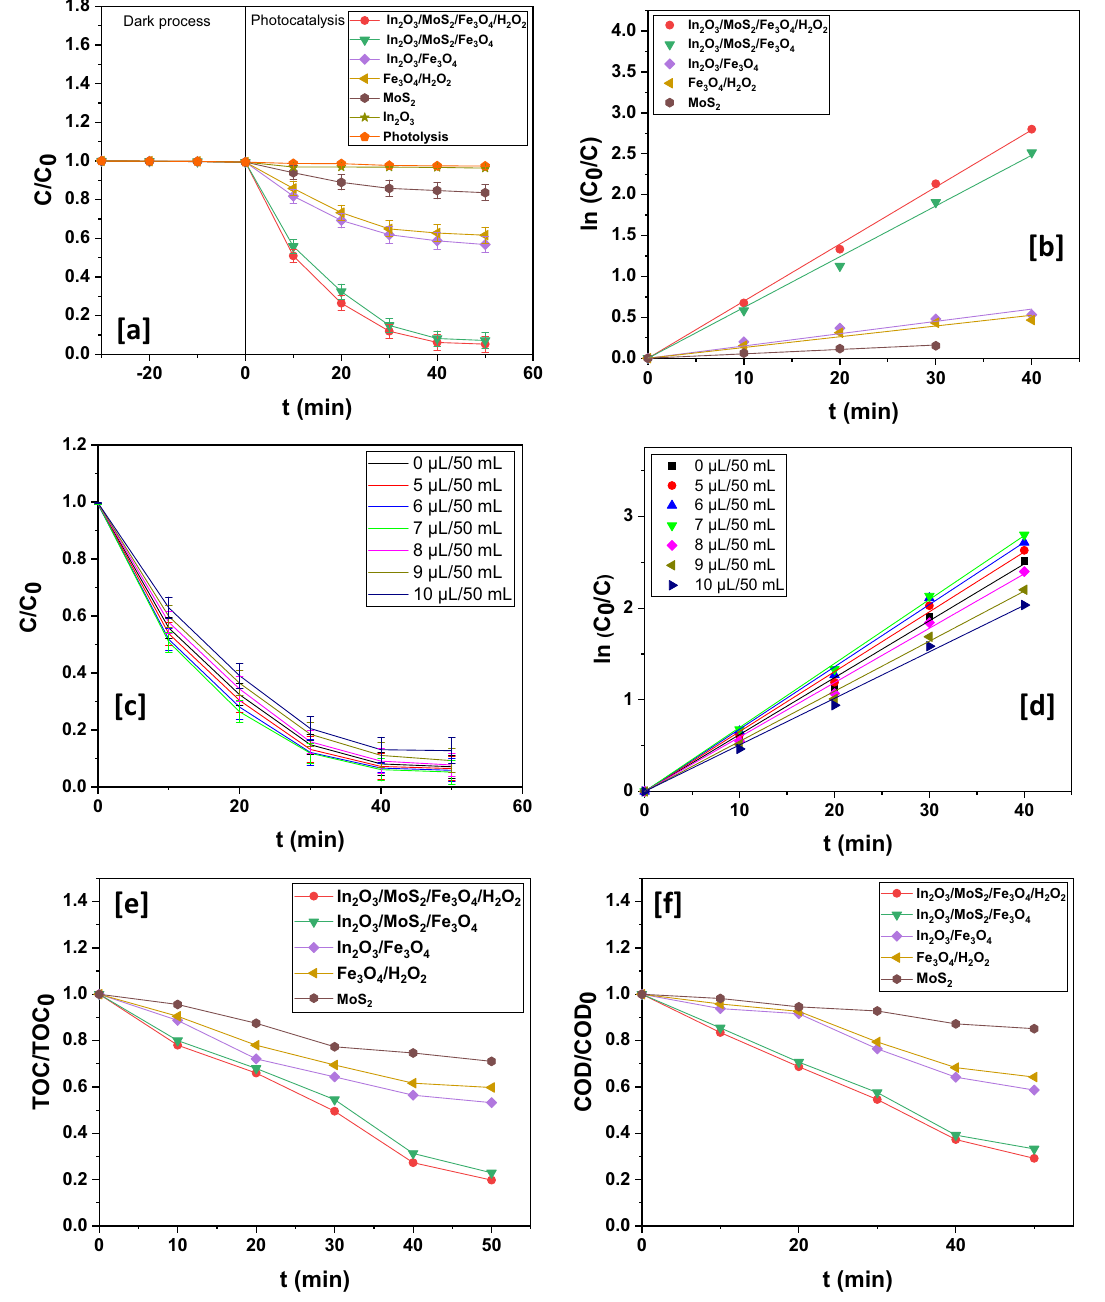
Figure 8. ( a ) Photodegradation dynamic curves of esomeprazole and ( b ) kinetics for different catalysts. ( c ) Photodegradation dynamic curves of esomeprazole at different H 2 O 2 doses over In 2 O 3 /MoS 2 /Fe 3 O 4 and ( d ) its corresponding kinetics. ( e ) Plot of TOC/TOC 0 vs. time. ( f ) Plot of COD/COD 0 vs.